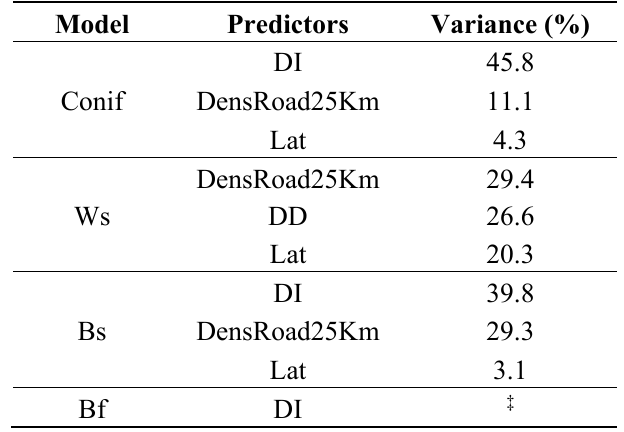
Table 5. Variance proportion of predictive variables for the